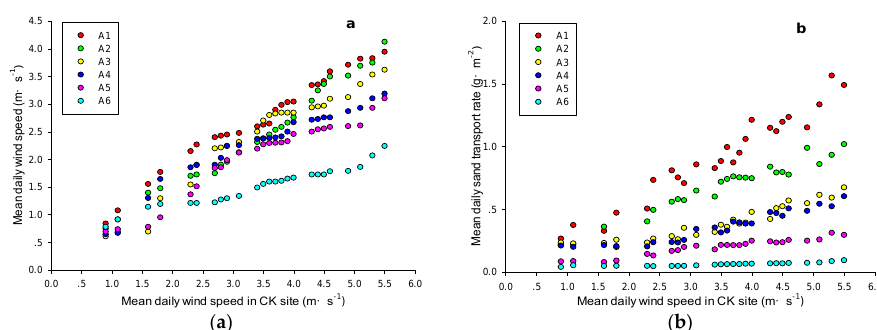
Figure 8. Relationships between poplar age and mean daily wind speed and daily sand transport rate: ( a ) relationship between mean daily wind speed at 2 ‐ m height in the six experiment sites with different ages and mean daily wind speed at 2 ‐ m height in the control site; ( b ) relationship between mean daily sand transport rate in the six experiment sites with different ages and mean daily wind speed at 2 ‐ m height in the control site.